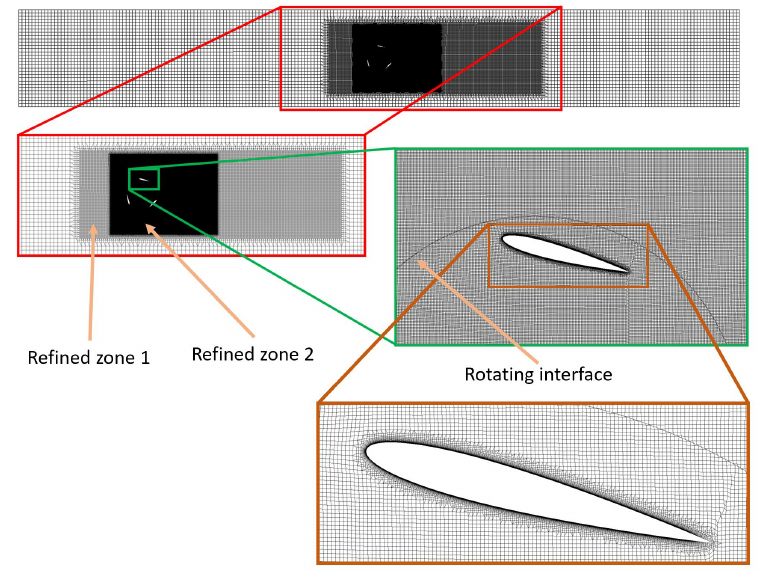
Figure 1. An overview of the meshing